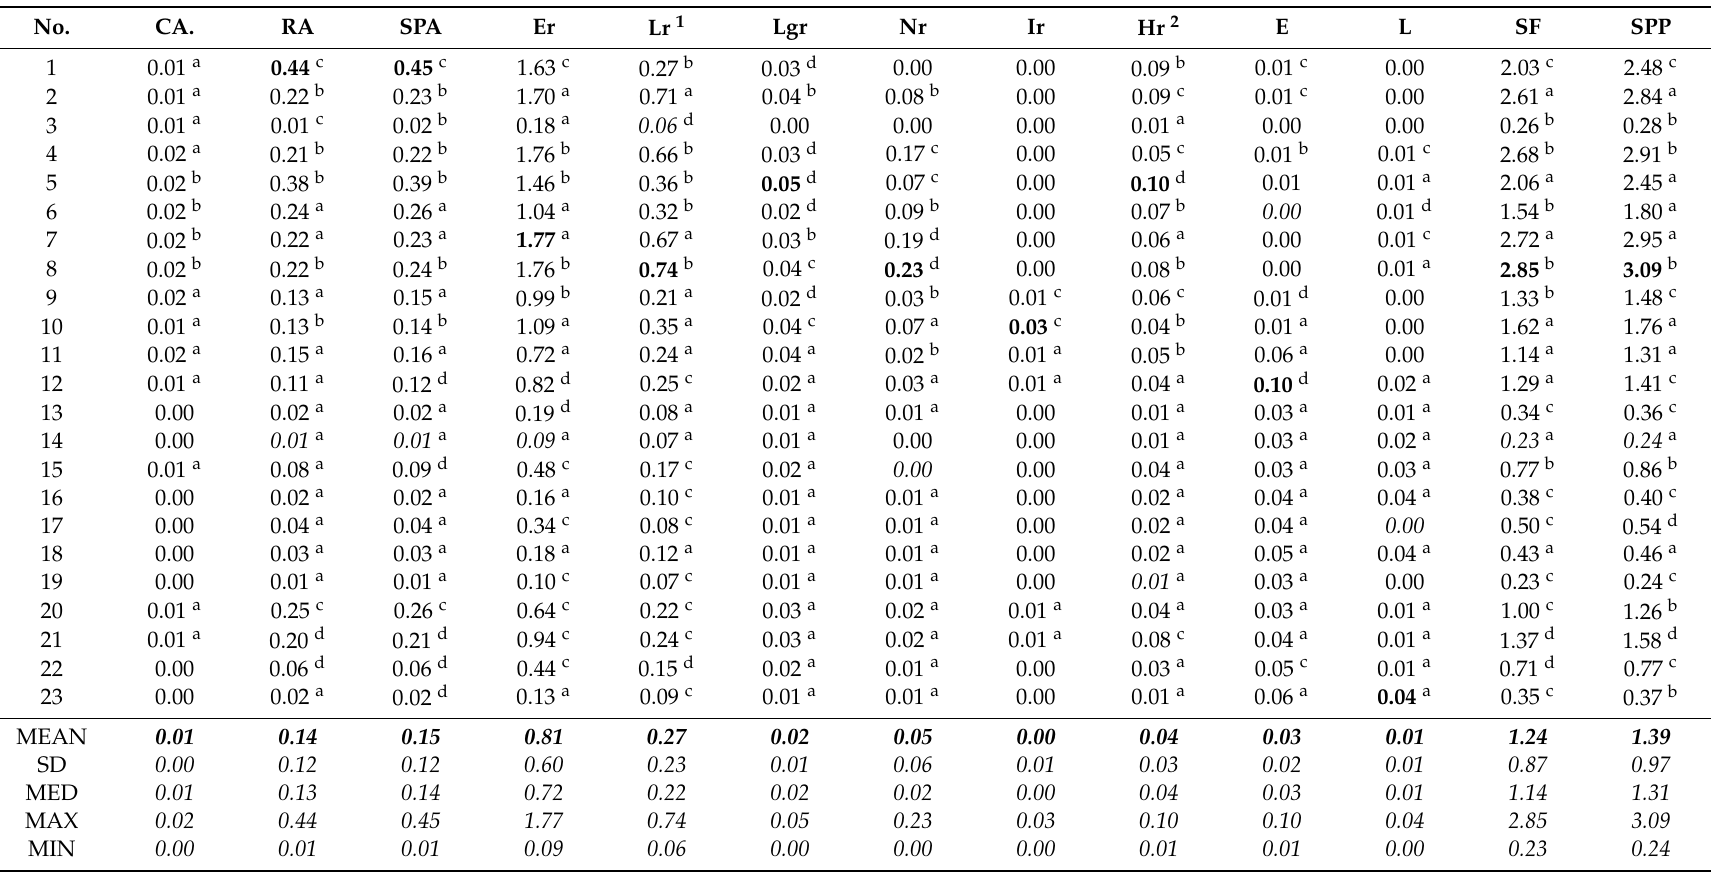
Table A1. Content of determined polyphenolic compounds in peppermint tinctures (mg /